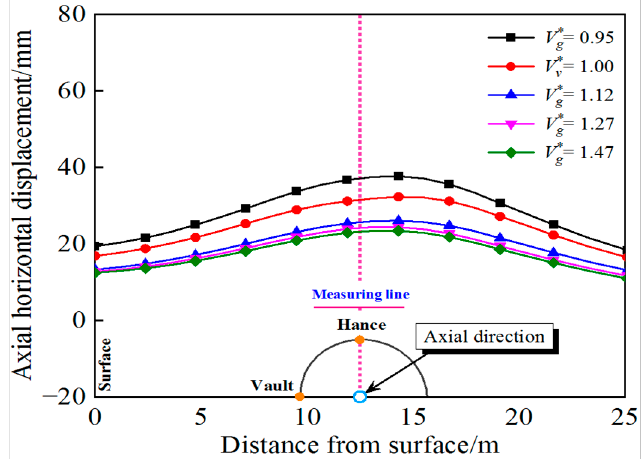
Figure 25. Horizontal deformation of the stratum along the axis direction under different synchronous